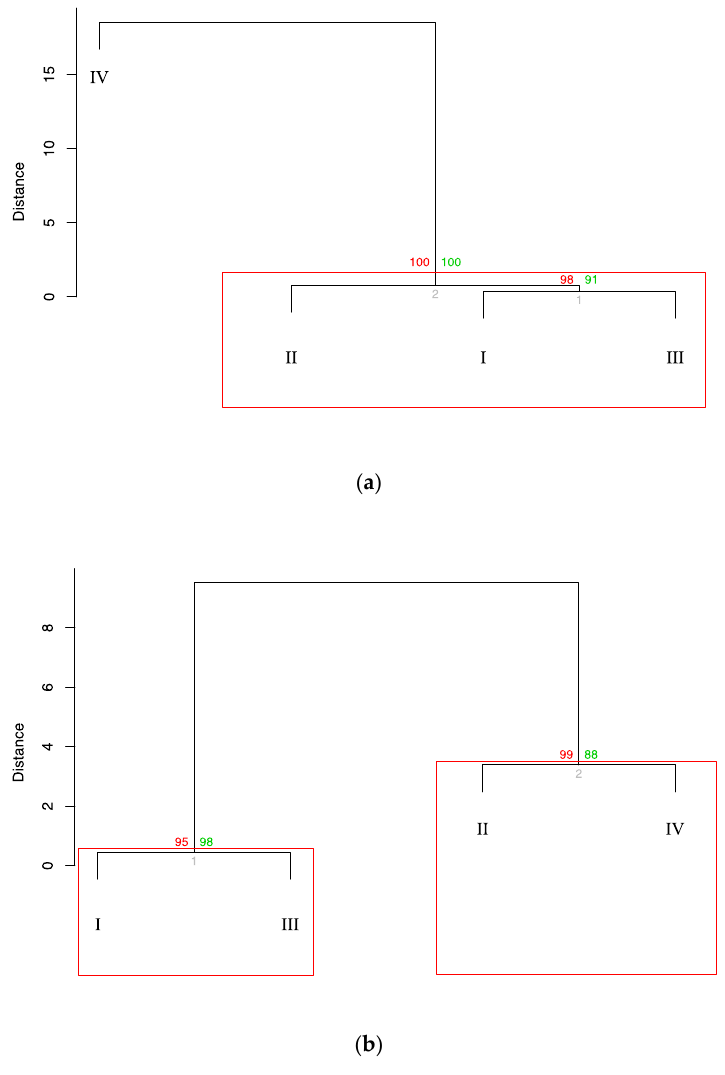
Figure 2. Ward’s hierarchical agglomerative clustering based on the chicken cecal microbiome profiles at 1 ( a ) and 7 dpi ( b ) and using a matrix of squared Euclidean distances between objects. Bootstrapping validation was performed using AU (approximately unbiased) p -values (%) and BP (bootstrap probability) values (%) shown with red and green estimates, respectively. Clusters with AU p -values greater than 95% are placed within red rectangles. Subgroups: I (negative control), II (SE challenge), III (Intebio ® intake), and IV (Intebio ® intake + SE challenge). Further, we performed Ward’s clustering by placing together the cecal microbiomes at 1 and 7 dpi (SI Figure S4) that generally confirmed the pattern of dendrograms built separately for the two time points (Figure 2), the within-cluster distances between sub- groups being mainly smaller at one time point.